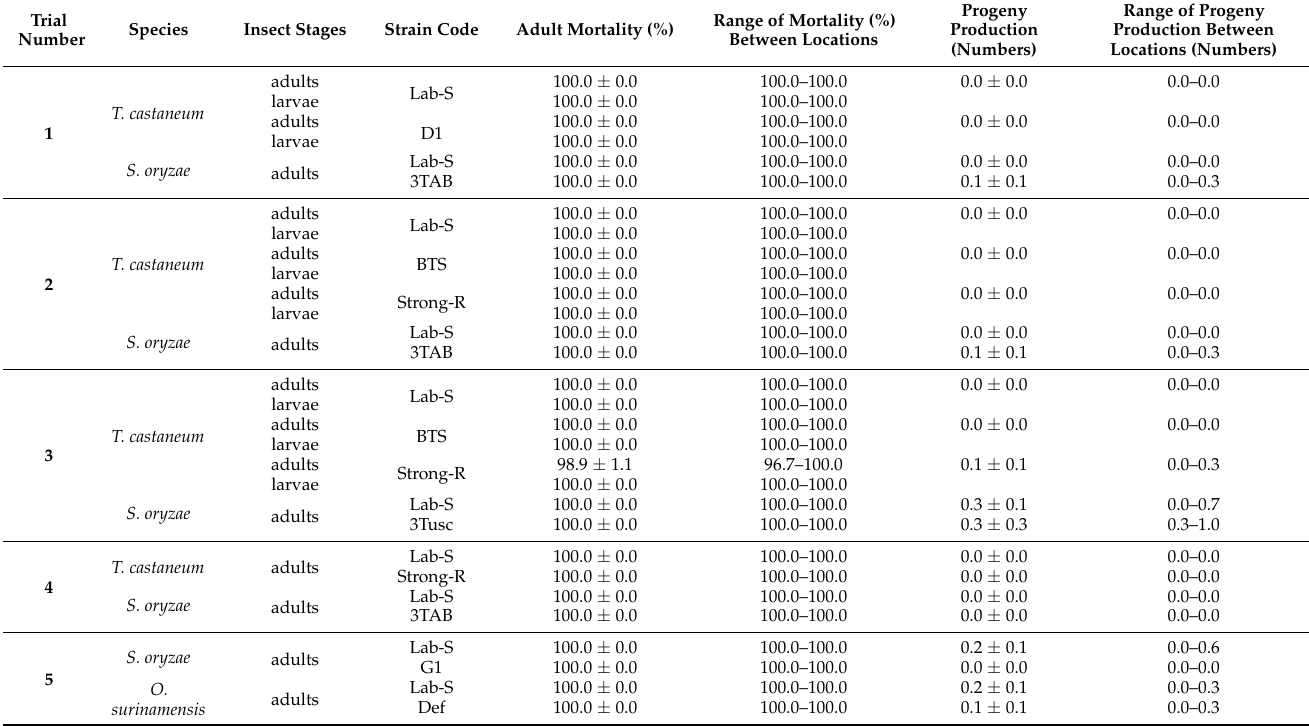
Table 3. Mean mortality (% ± S.E.) of four populations of T. castaneum (Lab-S, D1, Strong, BTS), four populations of S. oryzae (Lab-S, 3TAB, 3Tusc, G1), and two populations of O. surinamensis (Lab-S, Def) with different susceptibility to phosphine exposed to nitrogen, and progeny production (mean number of adults ± S.E./vial) 65 d later. For each treatment, no significant differences were recorded among the resistant and susceptible populations.